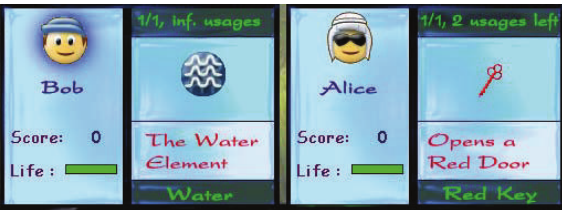
Figure 12: An example of player’s state and inventory as shown on Amby’s screen. Both players have their inventories open. The blue shadow behind Bob’s head indicates that it is his turn to play.